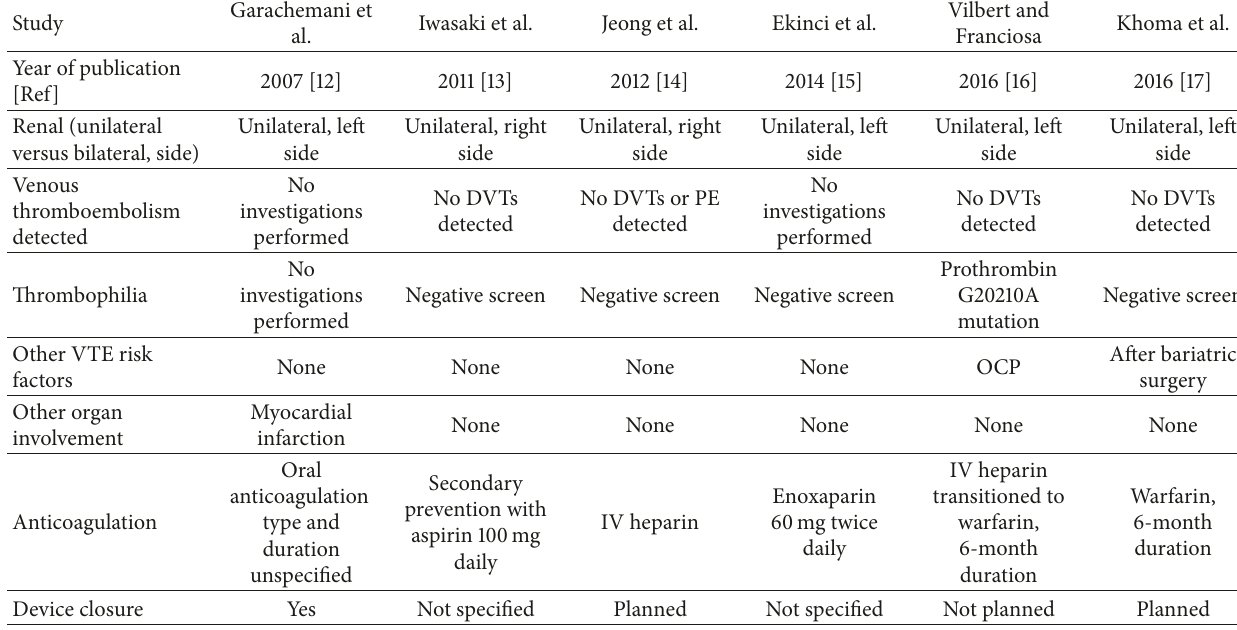
Table 1: Case reports of renal infarction associated with paradoxical embolism in the setting of a patent foramen ovale.